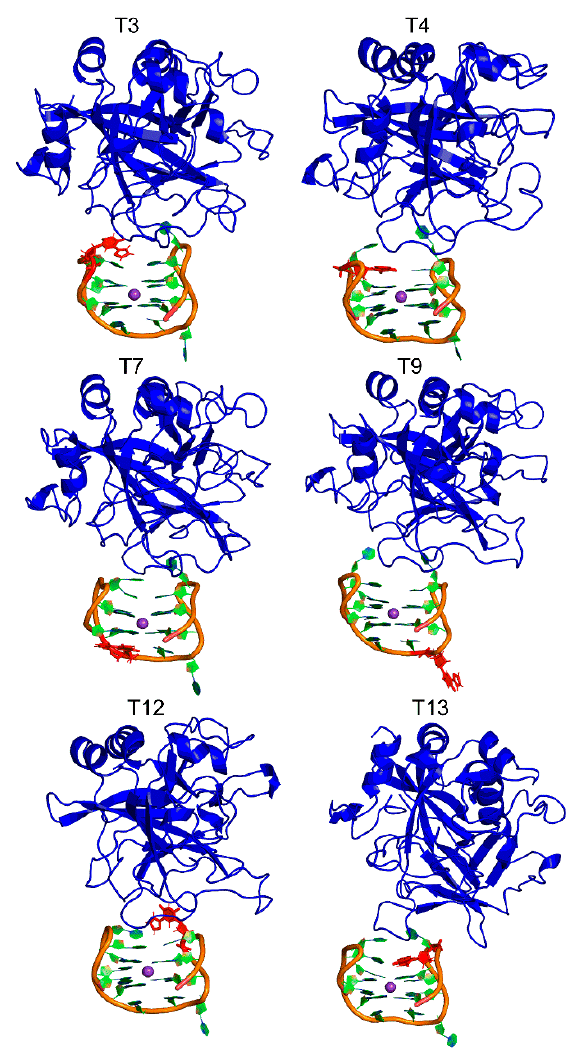
Figure 5. Representative MD structures of TBA containing 5FurU (red) bound to the thrombin protein (blue).